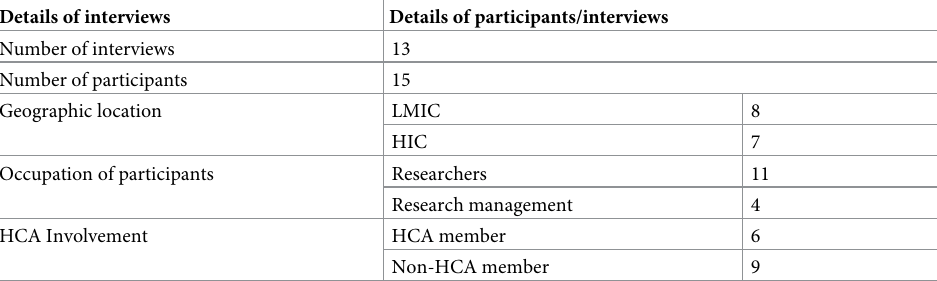
Table 1. Overview of the geographic location, occupation, and HCA involvement of research participants in this